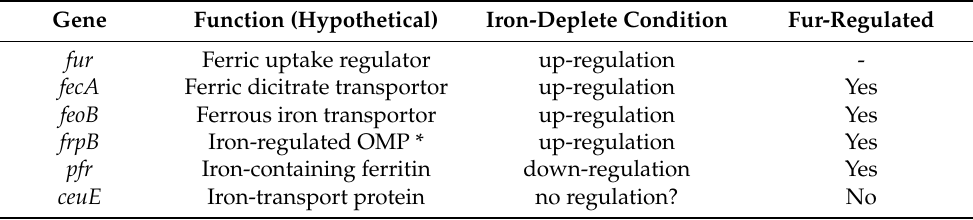
Table 1. Primary genes associated with iron uptake in H. pylori host infection and regulation of their expression by iron. Gene Function (Hypothetical) Iron-Deplete Condition Fur-Regulated fur Ferric uptake regulator up-regulation - Ferric dicitrate transportor